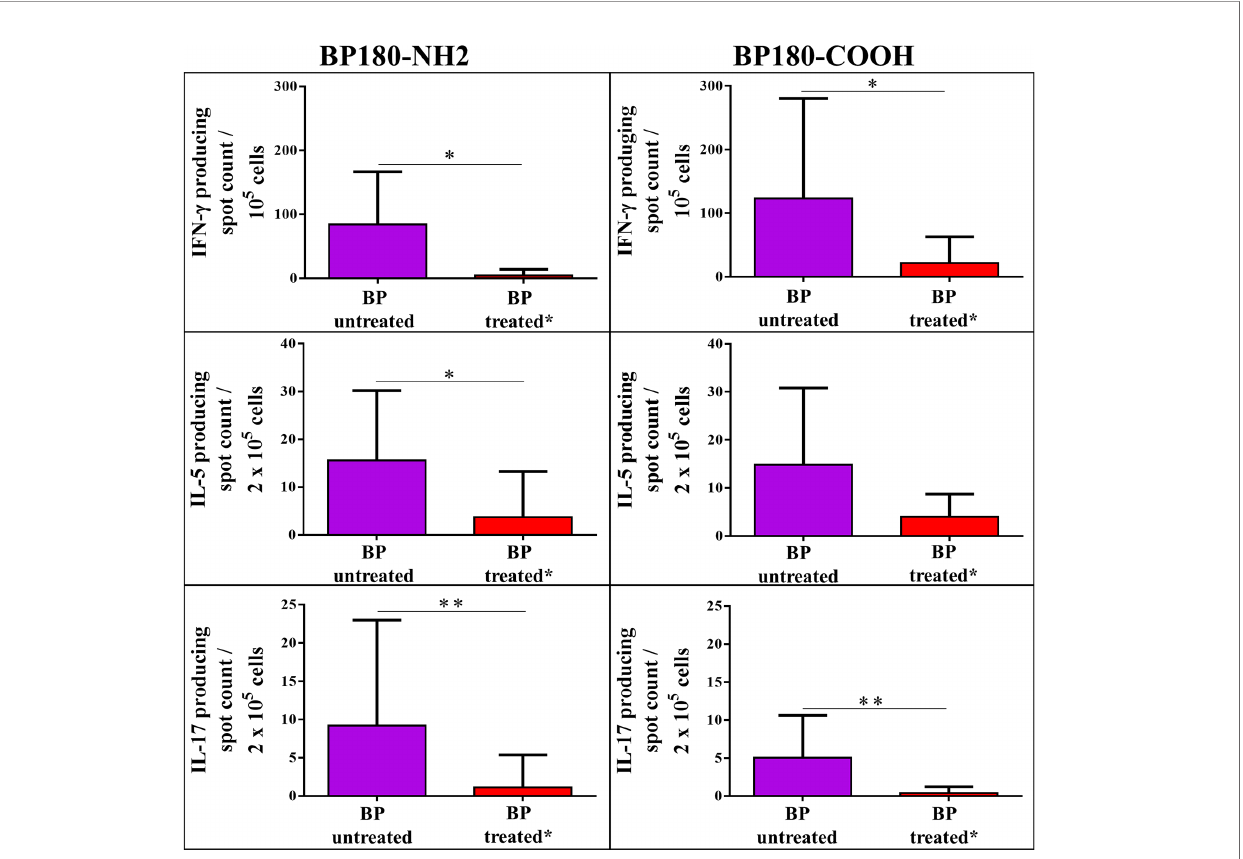
FIGURE 4 | Impact of treatment with topical glucocorticoids (clobetasol propionate ointment) on peripheral blood T cell responses against bullous pemphigoid (BP) 180 in BP patients. Shown are T cells producing IFN- g , IL-5 or IL-17 upon ex vivo stimulation with the immunodominant NH2-terminal NC16a domain of BP180 (BP180-NH2) or the COOH terminus of BP180 (BP180-COOH), respectively. BP patients with active disease were either untreated or had been treated topically with 0.05% clobetasol propionate ointment for at least 5 days. Differences between the groups were analyzed using Mann-Whitney U-test for non-parametric data (*p < 0.05, **p <